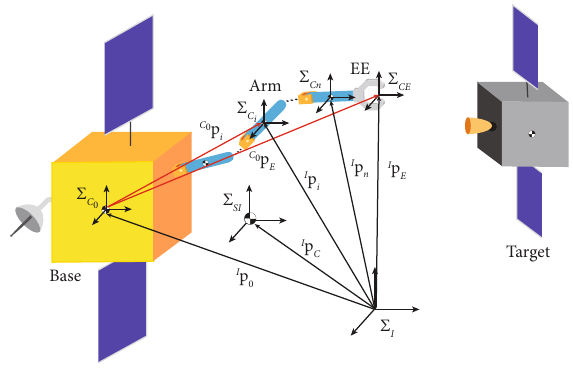
Figure 1: Model of the space robot